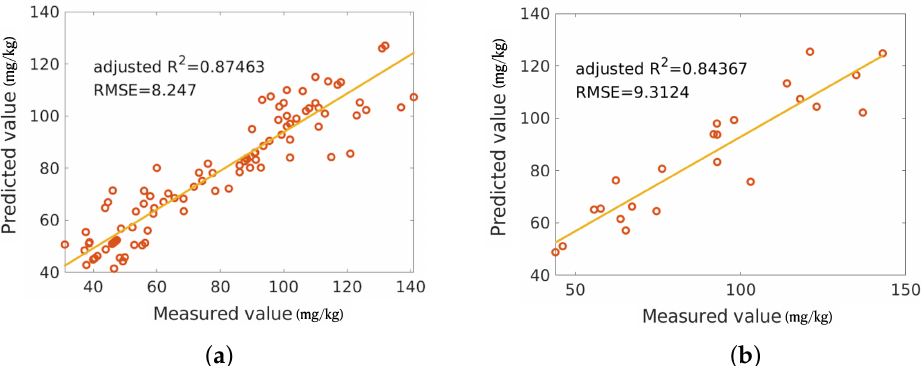
Figure 6. Scatterplot of the best SVR model for Cu concentration estimation on ( a ) the training dataset and ( b ) the test dataset.